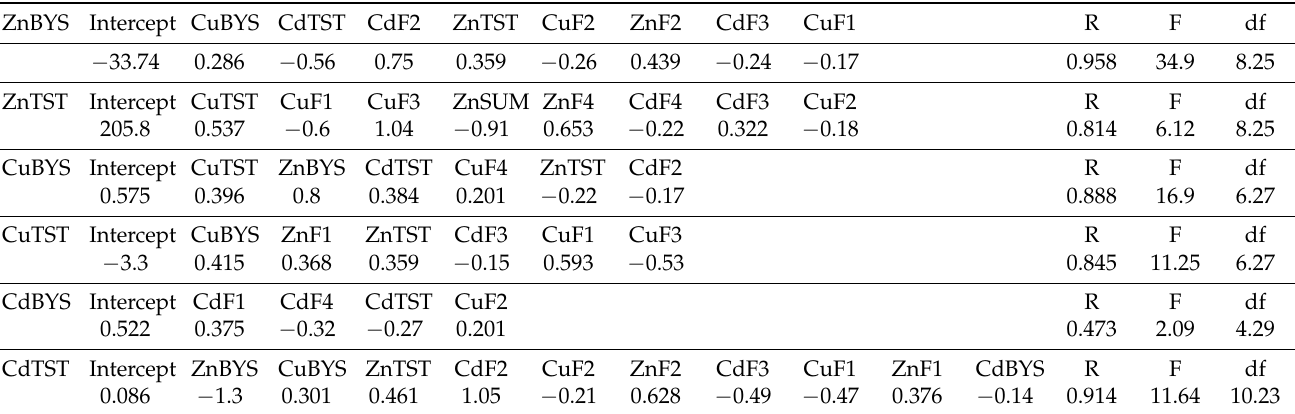
Table 5. Multiple linear stepwise regression analytical outputs based on byssus (BYS) and total soft tissue (TST) of Perna viridis as dependent variables; independent variables are the geochemical fractions of the six metals collected from 34 populations in the coastal waters of Peninsular